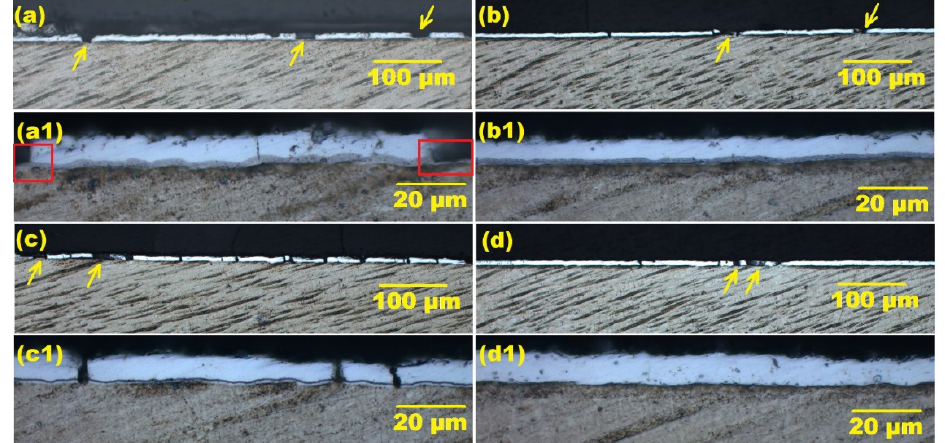
Figure 4. Optical images of the cross-section microstructure of the E110 alloy samples with ( a , a1 ) ZrO 2 /Cr-100, ( b , b1 ) ZrO 2 /Cr-250, ( c , c1 ) ZrO 2 /Cr-750 and ( d , d1 ) ZrO 2 /Cr coatings after the short-term thermal cycling. The arrows indicate spallation of the coatings.